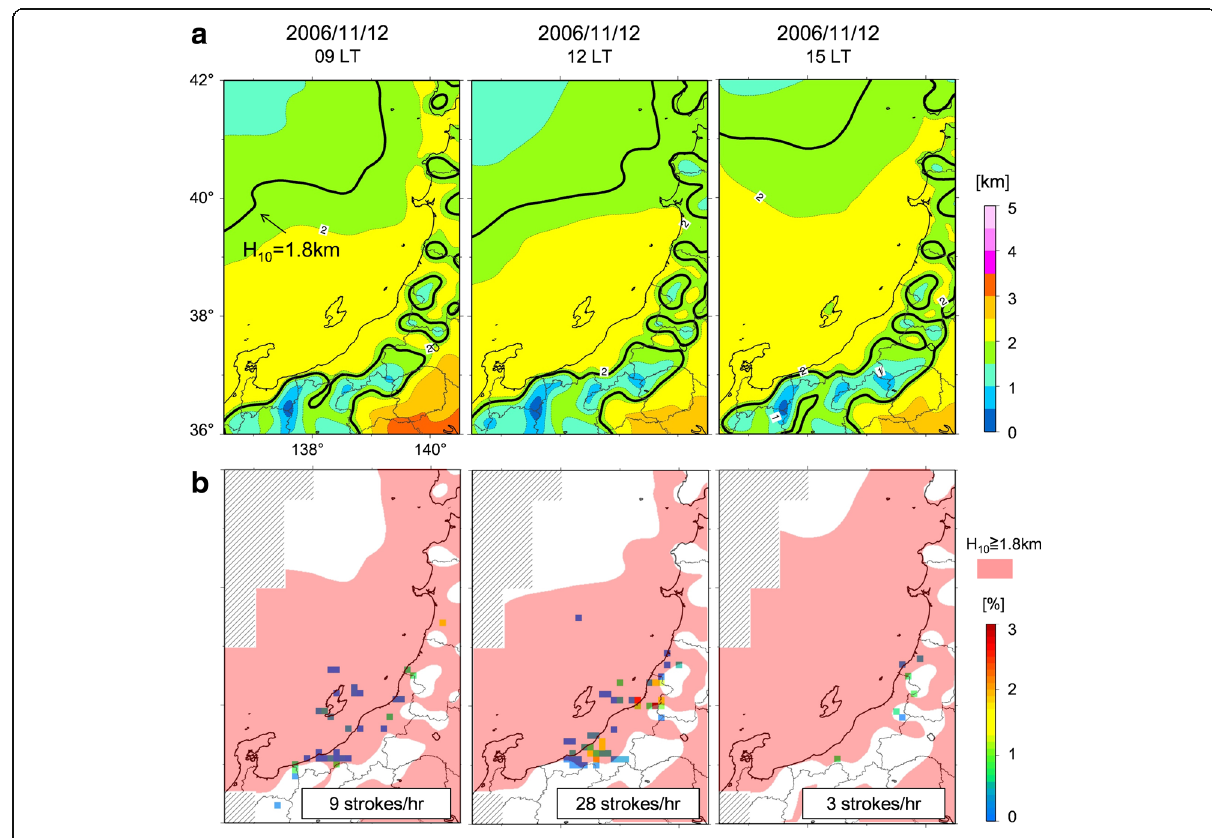
The lightning frequency distribution of case A is mainly determined by the cold front that accompanied the SK cyclone. The lightning frequency distributions of cases B and C, on the other hand, were mainly determined by topo- graphic convergence and convective instability rather than by cold fronts. The difference between case A and case B could be the strength of the cold front. Figure 20 com- pares the vertical p -velocity values at 850 hPa for case A and case B. The updraft near the cold front is weaker in